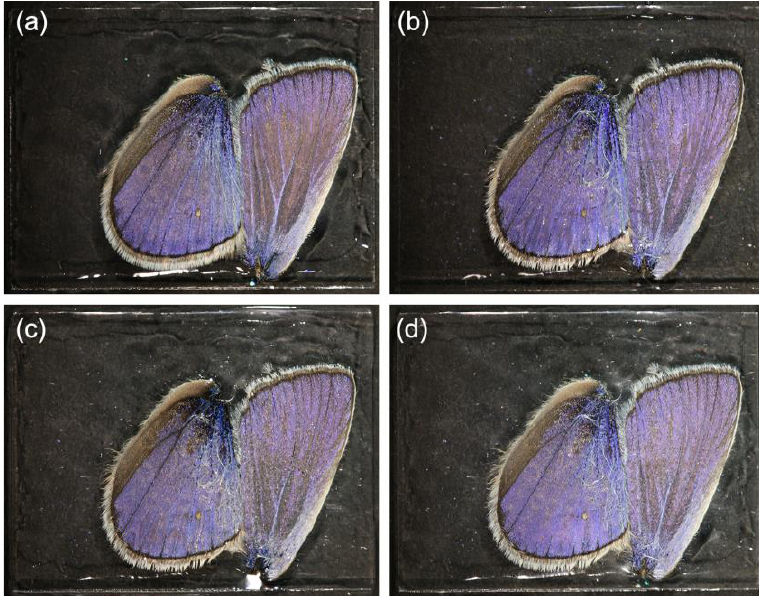
Figure 1. The Polyommatus icarus wings mounted on glass slides after 6 days of immersion in water (in horizontal position) did not lose structural color but suffered some redshift, indicating a moderate swelling of the chitin nanoarchitecture. ( a ) Pristine dry wings; ( b ) wings immediately after immersion; ( c ) wings after 6 days of immersion, removed from water; ( d ) wings 5 h after removing from water.